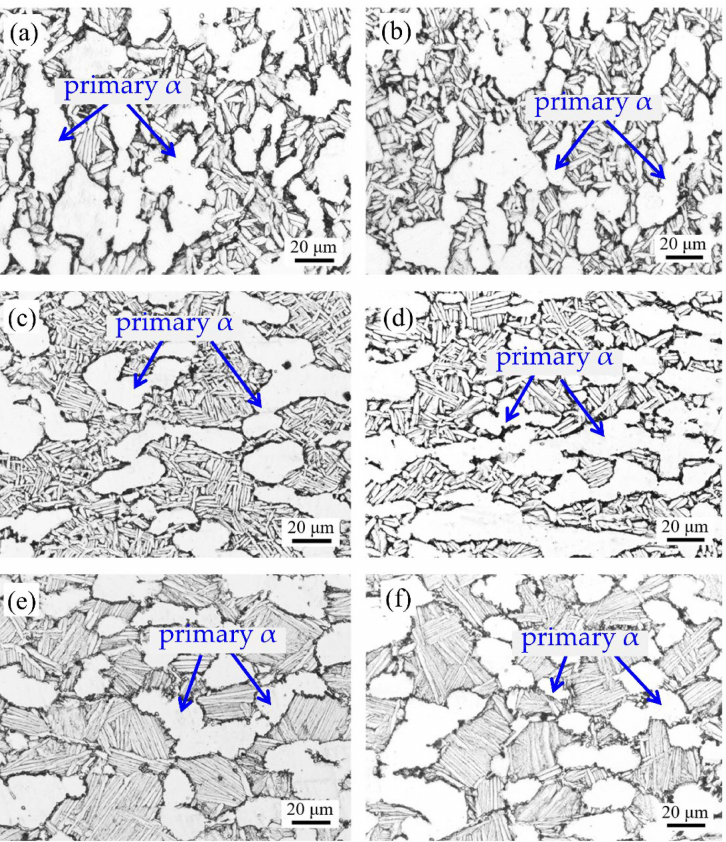
Figure 16. Microstructure of different heat treatments: ( a , b ) correspond to the first heat treatment, ( c , d ) correspond to the second heat treatment, and ( e , f ) correspond to the third heat treatment.